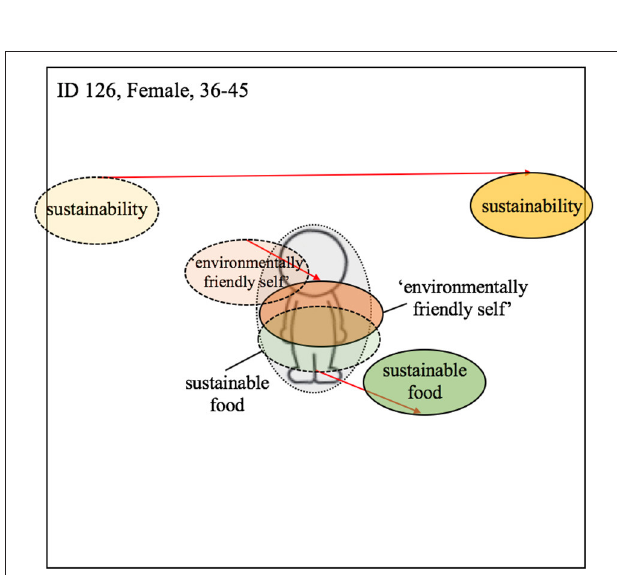
FIGURE 7 | Visualization of centrality of identity—Lack of spillover; Dashed line = T1; solid line and darker coloring = T2; Red arrow indicates change from T1 to T2 (the colors were added after the